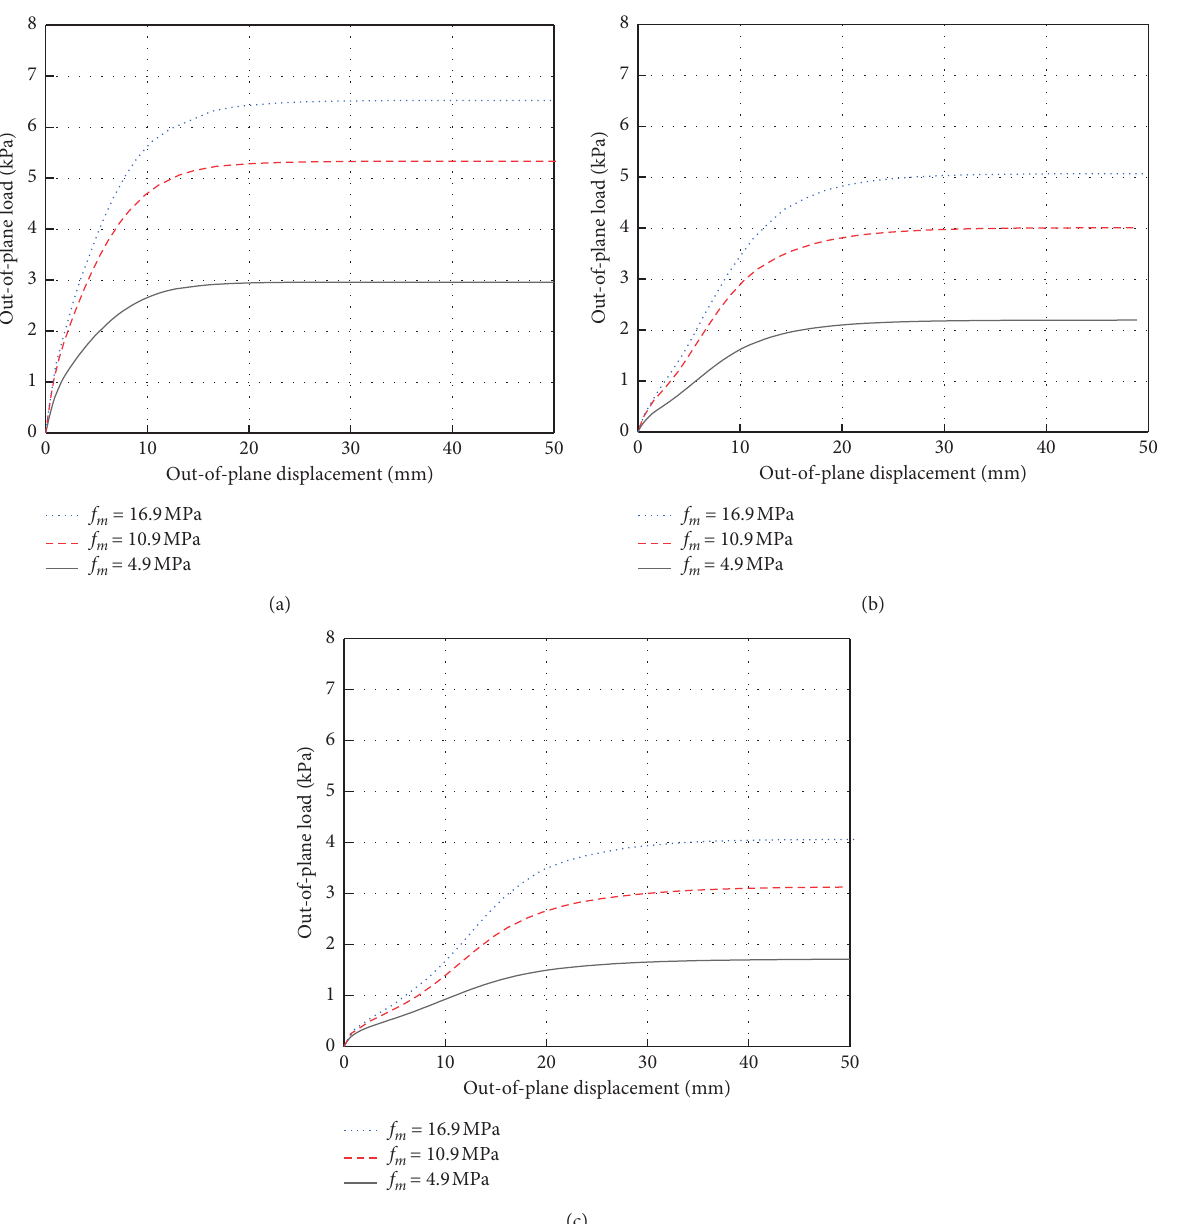
Figure 9: OOP load-displacement curves of infill walls with different masonry strengths. (a) Without IP damage. (b) With IP damage (IDR � 0.3%). (c) With IP damage (IDR �